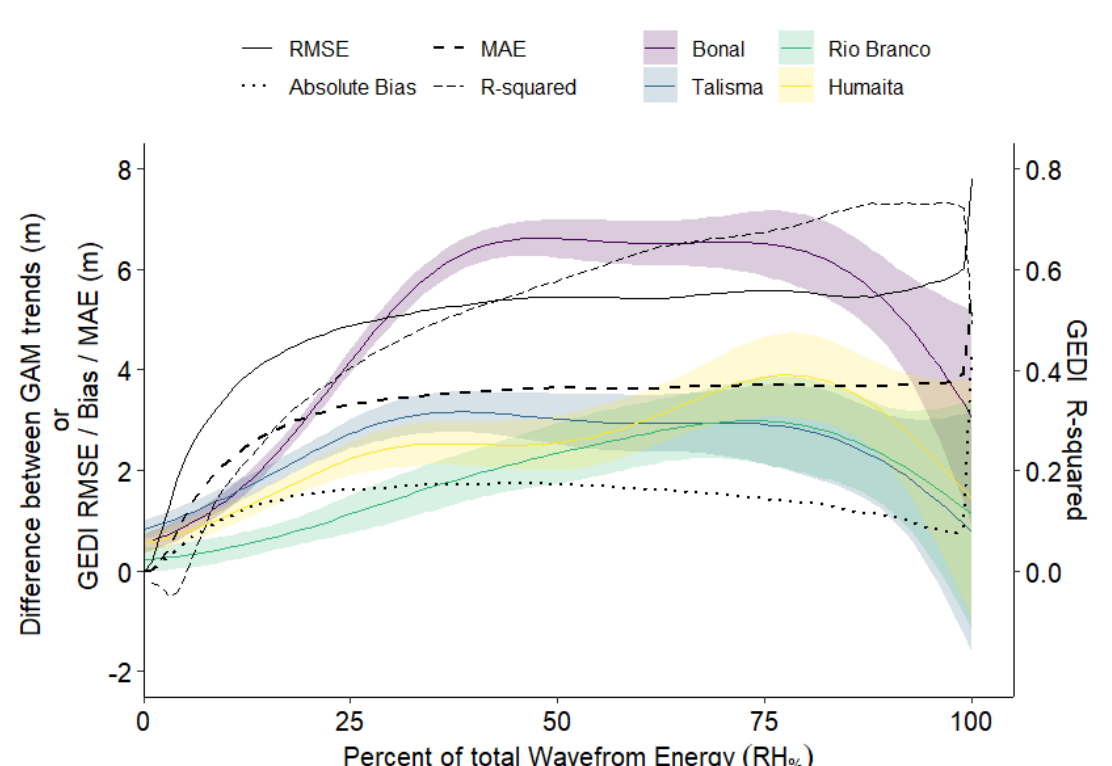
Figure 10. Comparison between the fire-induced forest structural change (colored line and confidence intervals), and the GEDI accuracy estimate measurements from East et al. 2022: root mean square error (solid black line), MAE (thick dashed line), bias (dotted line), and R-squared (dashed line) [35]. Note that the forest structural differences, GEDI RMSE, MAE, and bias are all measured in meters, while R-squared is on a unitless relative scale.